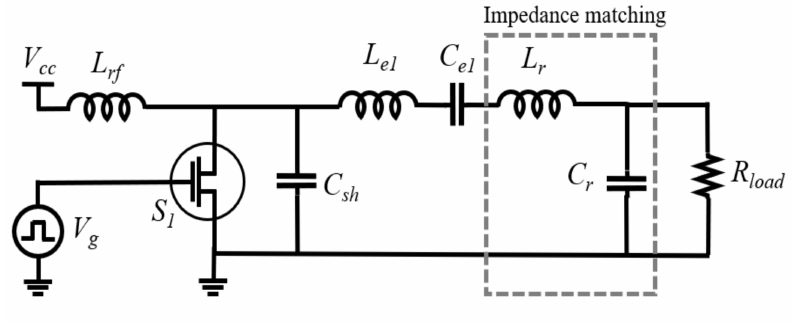
Figure 12. Class-E power inverter with an impedance matching